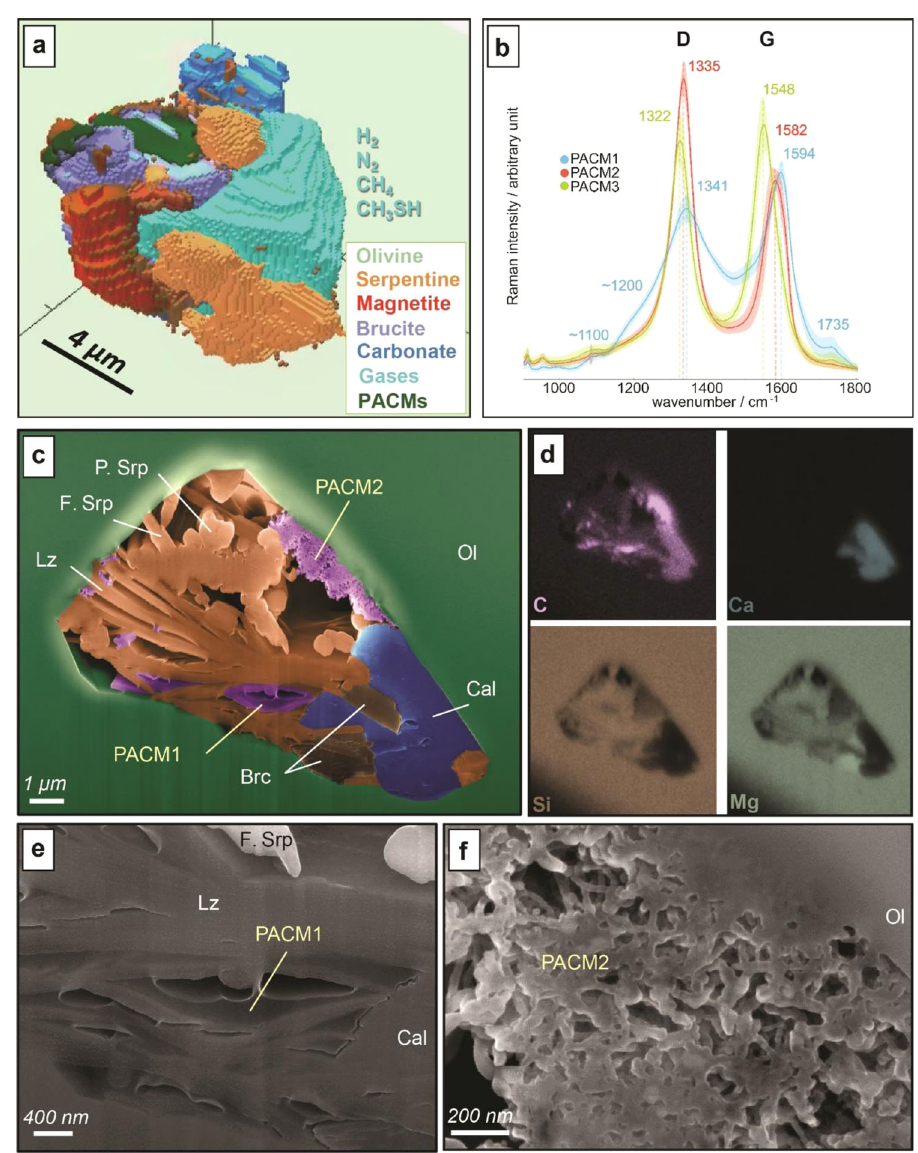
Fig. 3 | Diversity of gaseous and condensed abiotic organic compounds asso- ciated with secondary minerals in single fl uid inclusions trapped in olivine mineralsofthedeepoceaniclithosphere.a ThreedimensionalRamanimagingof fl uid inclusion FI3 showing polyaromatic carbonaceous materials (PACMs) 33 – 36 coexisting with reduced gaseous species identi fi ed as H 2 , N 2 , CH 4 , and CH 3 SH and micrometric serpentinization-derived mineral phases 109,111 (i.e., serpentine, brucite, magnetite, and carbonate). See also Supplementary Movie 1. b Raman spectra highlighting the 3 end-member types of PACMs in the two individual fl uid inclu- sions (FI3 and FI5), all characterized by two broad bands assigned to the disorder (D) band and the graphite (G) band but showing variable position, intensity and width.Foreachend-member,ameanRamanspectrumispresented(boldline)with